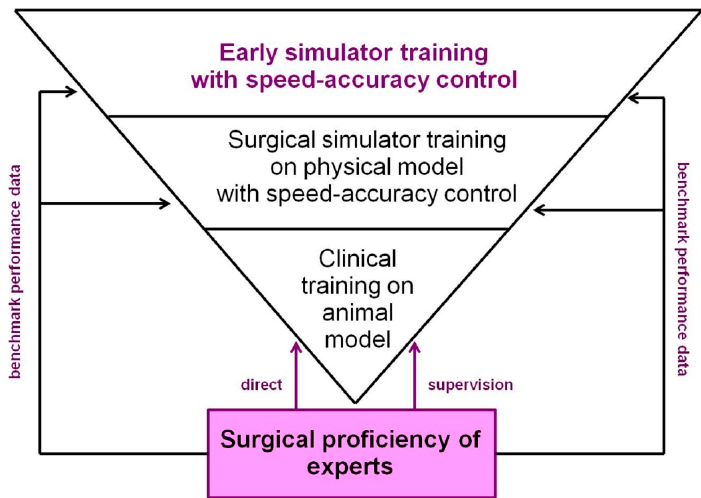
Figure 5. Speed–accuracy control on novice strategies in early training systems based on experts’ benchmark performance data allows selection for critical aspects of surgical skill that will transfer to further training on physical models in increasingly realistic surgical tasks. Ultimately, this will produce a valid selection of trainees that are likely to perform well at the highest levels of training under the direct supervision of an expert.